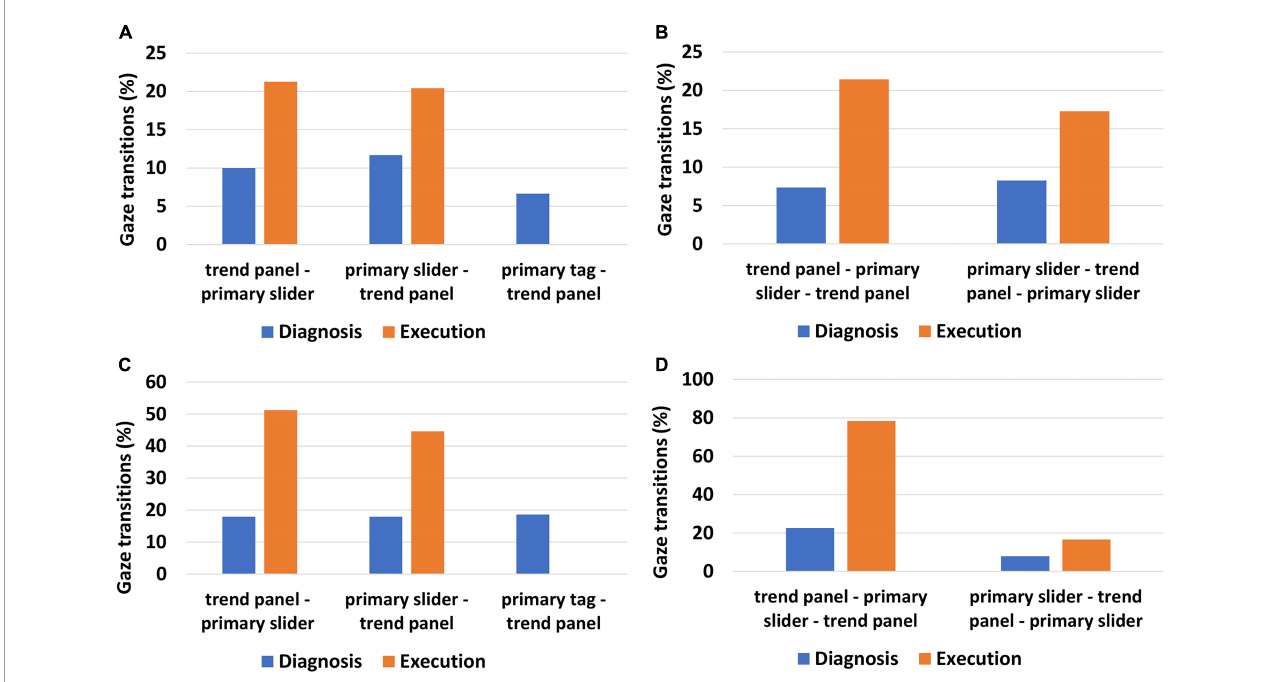
FIGURE5 Gaze transition analysis during diagnosis and execution phase (A) two tuple gaze transition for human participants for successful trials (B) three tuple gaze transition for human participants for successful trials (C) two tuple gaze transition for the human digital twin for successful trials (D) three tuple gaze transition for the human digital twin for successful trials.